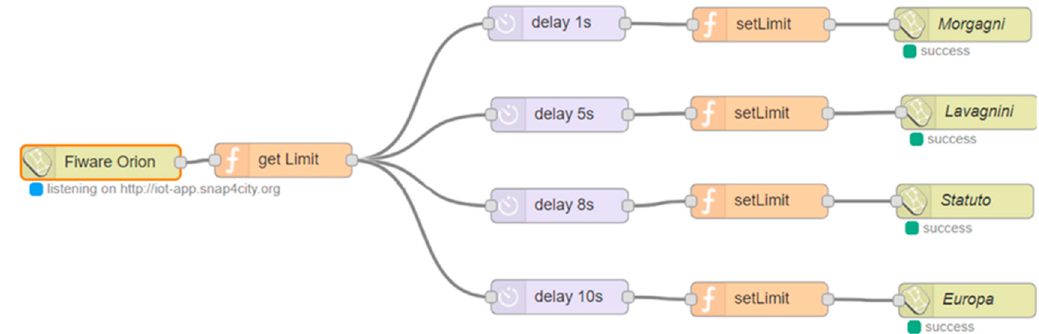
Figure 17. Flow that allows the city operator to read from an entity connected to the dimmer and write these values to four other entities connected to the road signs in the control room. These entities reside within an IoT